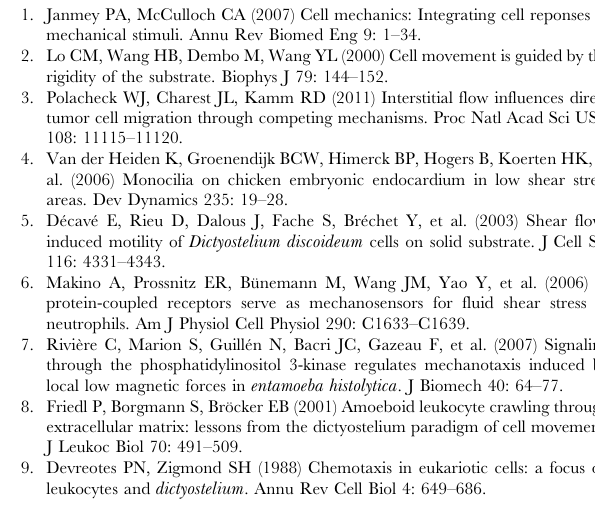
Figure S3 Cell Kinematics: Average displacement along the signal direction for different flow reversal frequen- cies. The scale along the y -axis is taken identical to the scale used in Fig. 5(b) to allow for an easier comparison of the fine details of the course reversal. (a) Zoom-in for the only reversal correspond- ing to the switching period 175 s ; (b) Zoom-in for the first reversal corresponding to the switching period 87 : 5 s ; (c) Zoom-in for the second reversal corresponding to the switching period 87 : 5 s . Figure S4 Prescripted cellular course. Left column: (Movie S2) right, trapped and left. Right column: (Movie S3) right, trapped, left and right. For each column: (a) Desired cellular output; (b) Imposed externally controlled mechanostimulus; (c) Measured cellular displacement in the x direction; (d) Instanta- neous snapshot of the cell in the observation area at instant t ~ 350 s. The red arrow indicates the mechanostimulus direction. The extracellular calcium concentration is 3 mM. Figure S5 Schematic of cell kinematic parameters. The cell position, corresponding to its centroid position, is represented as successive points at instants t i and t i z 1 in Cartesian coordinates. In all our experiments, the shearotactic signal is aligned with the x - axis but its direction is given either by the positive or the negative x -direction. Table S1 Detachment rate (DR) for unpolarized vege- tative Dd cells crawling on a plastic hydrophobic surface over a time span of 1200 seconds for different shear stress levels and different extracellular calcium concen- trations. Each entry is calculated using populations comprising